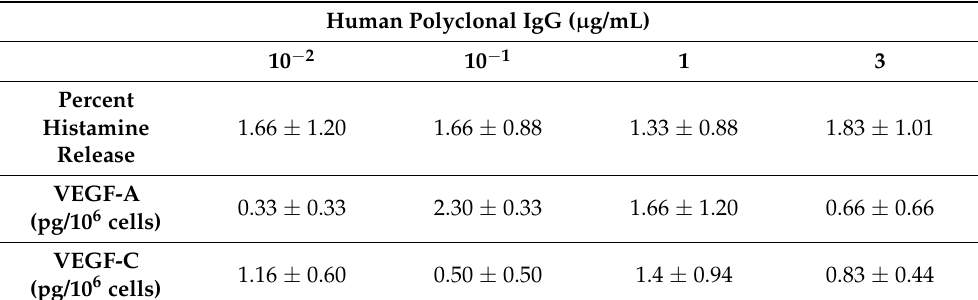
Table 2. Effect of human polyclonal IgG on histamine release and the production of VEGF-A and VEGF-C from human lung mast cells.